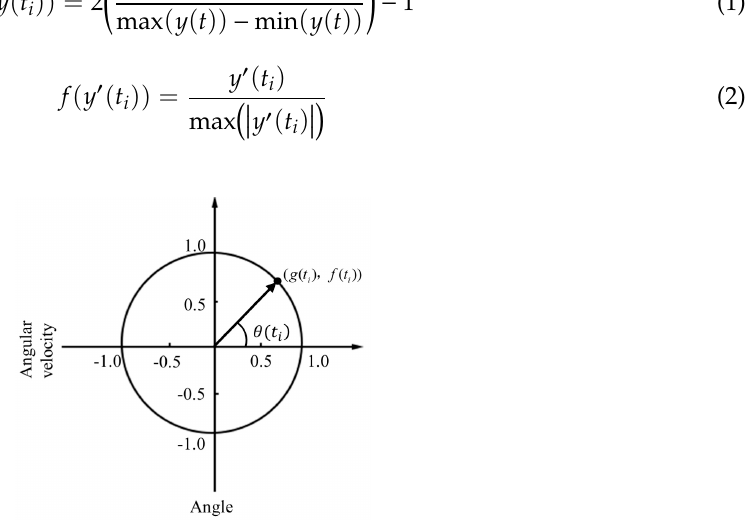
Figure 2. Definition of the phase angle in a phase portrait.